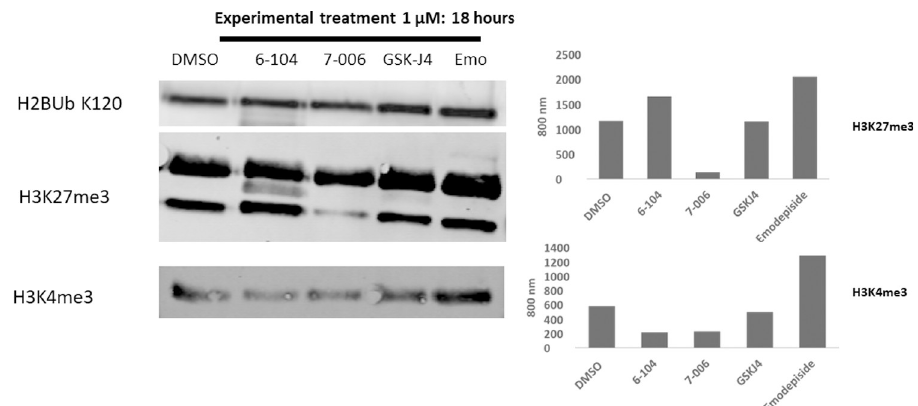
Fig 4. Left: B. malayi female western blot, treated with indicated compounds and vehicle control for 18 hours. Histones were extracted and purified and run on a 12% Bis-Tris gel. H2B ubiquitination on Lys120 was used as a loading control as it has been found to be constant regardless of experimental treatment in previous experiments. 6–104, an inactive structural analog was used as a negative control. 6–104, GSK-J4 and Emodepside do not appear to inhibit H3K27 demethylation. Right: Graphical representation of the western blot by normalization of H3K27me3 (top right) and H3K4me3 (bottom right) to loading control. Image: Odyssey CxL Image Studio.